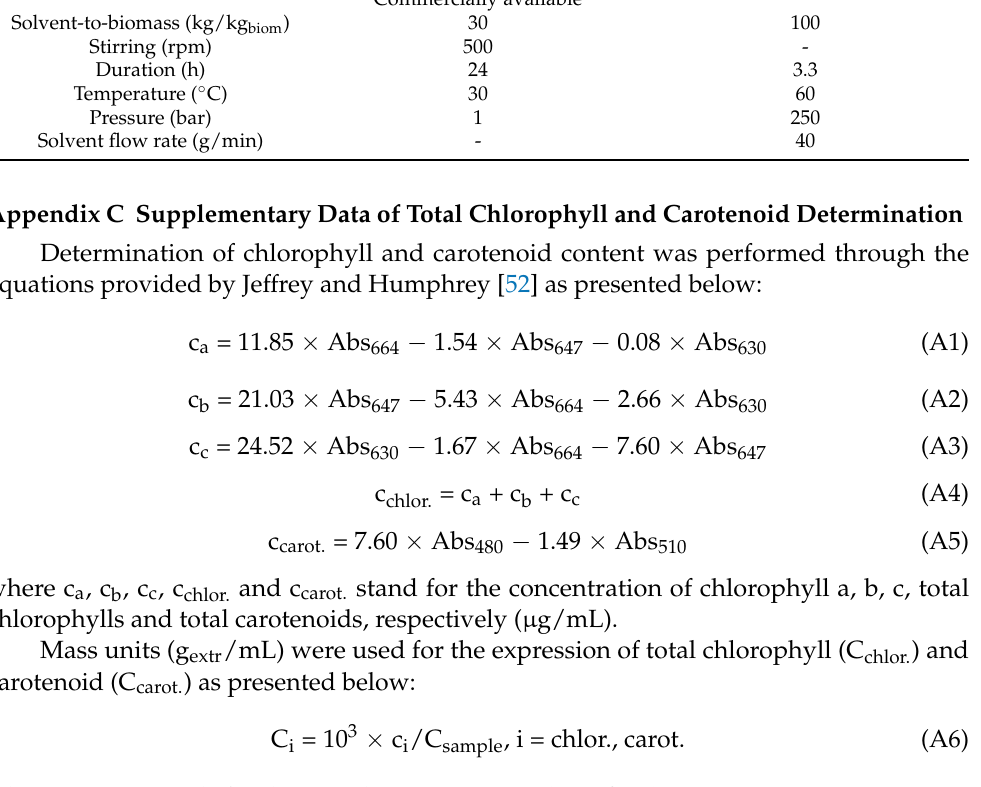
SLE cult. SLE com. [25] Laboratory cultivated/ Commercially available